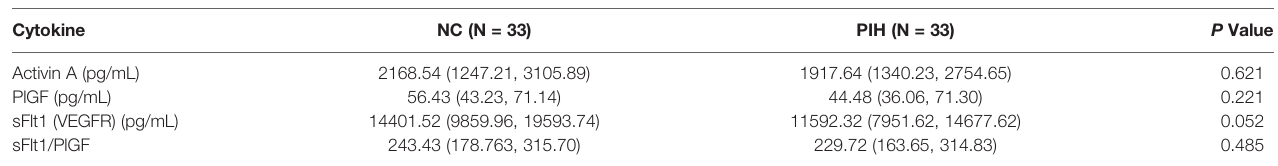
TABLE 2 | Classical serum biomarker levels in pregnancy after assisted reproductive technology. Cytokine Activin A